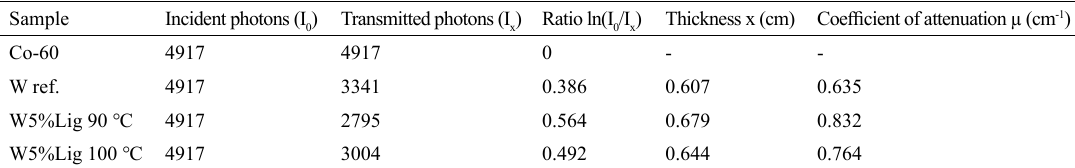
Table 1. Coefficient of attenuation of gamma radiation for different samples of the composite W-lignin.